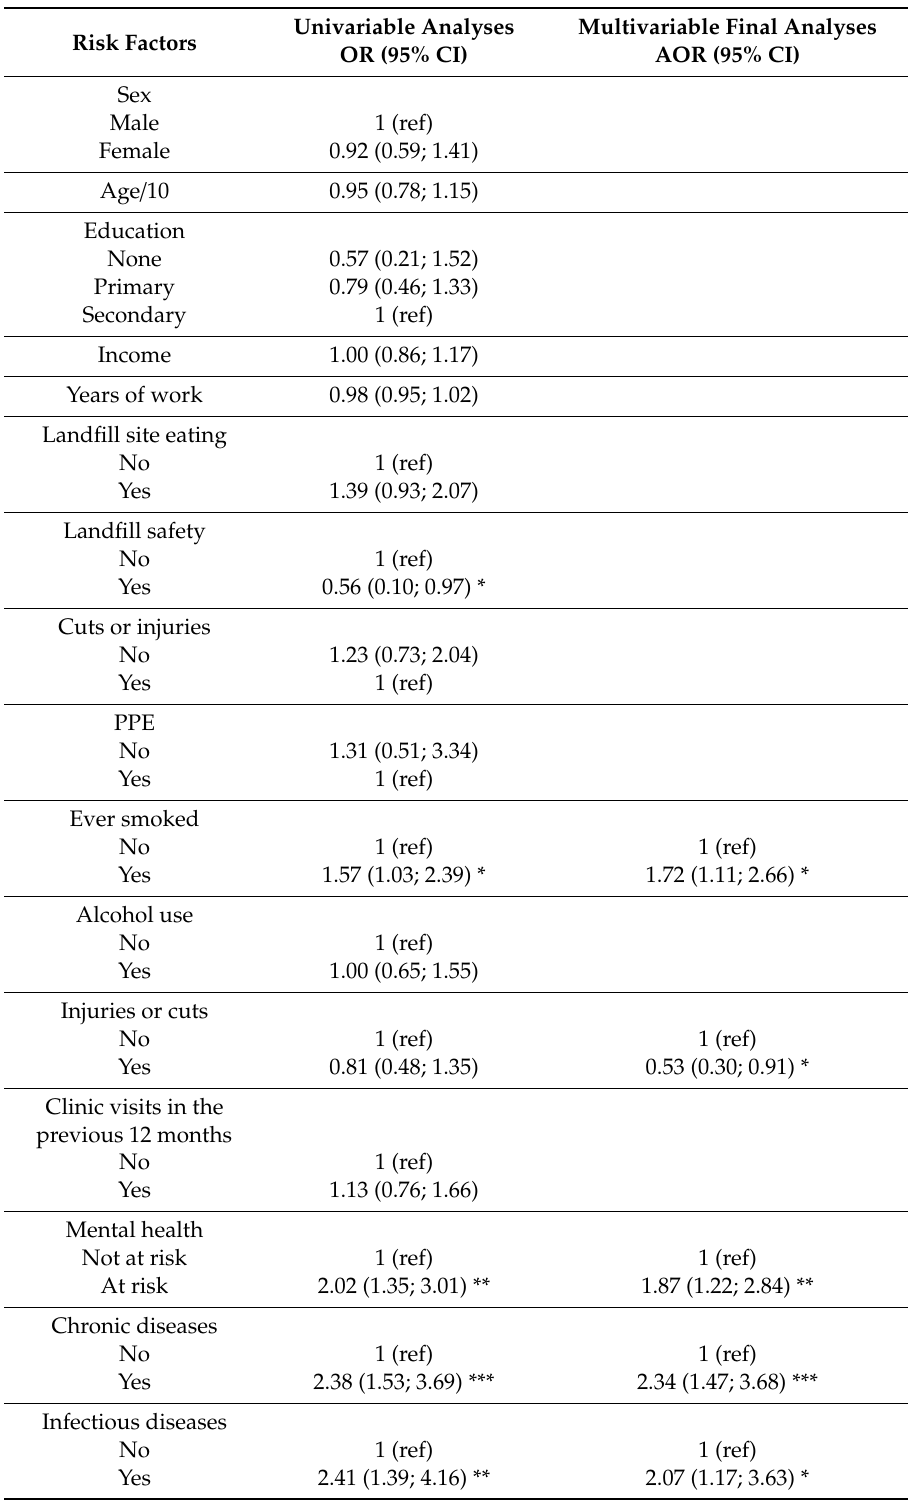
Table 2. Investigation of the association between illness, clinic visits and self-rated health. Risk